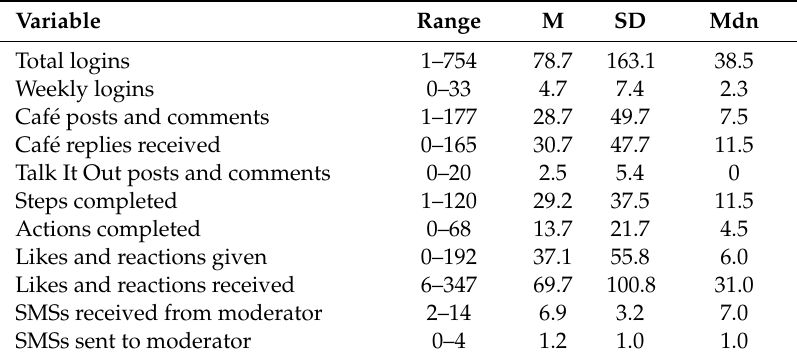
Table 5. Activity on A ffi